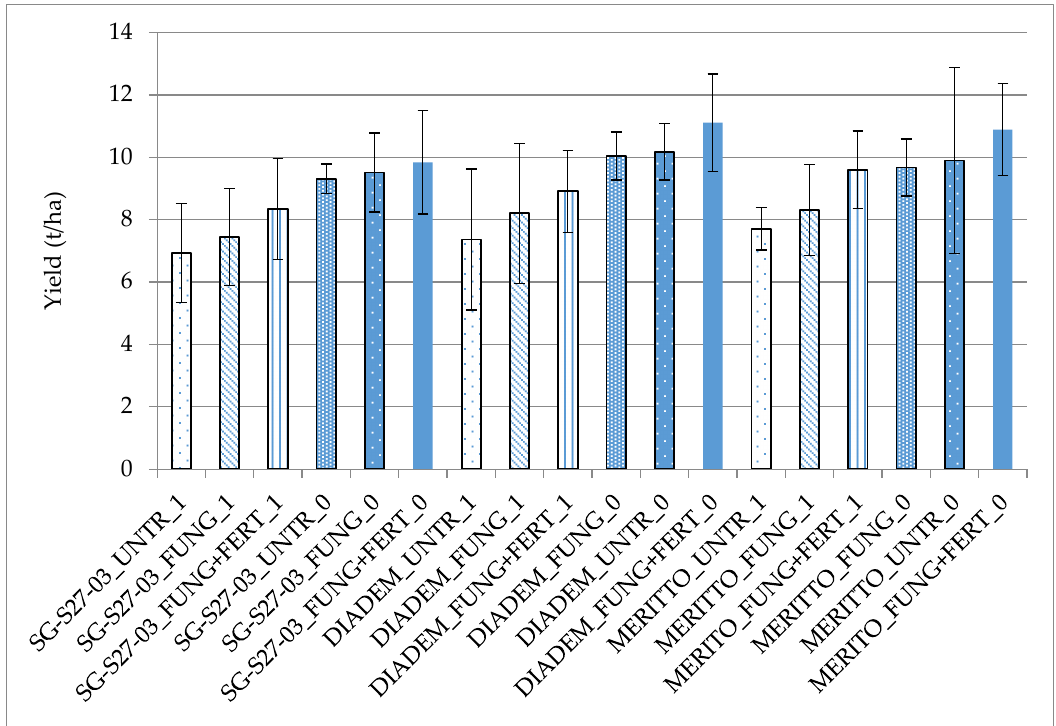
Figure 1. Grain yield for wheat cultivars infected with BYDV-PAV and treated with N. Cultivars: SG-S 27-03, susceptible to BYDV-PAV. Diadem, moderately resistant / moderately susceptible. Meritto, moderately resistant. Bars on each column are standard error. 1 = BYDV-PAV infection, 0 = uninfected control. UNTR = treated only with basic NPK fertilizer. FUNG = treated with basic NPK fertilizer and with 1–2 fungicides. FUNG + FERT treated with an increased dose of NPK and with fungicide.